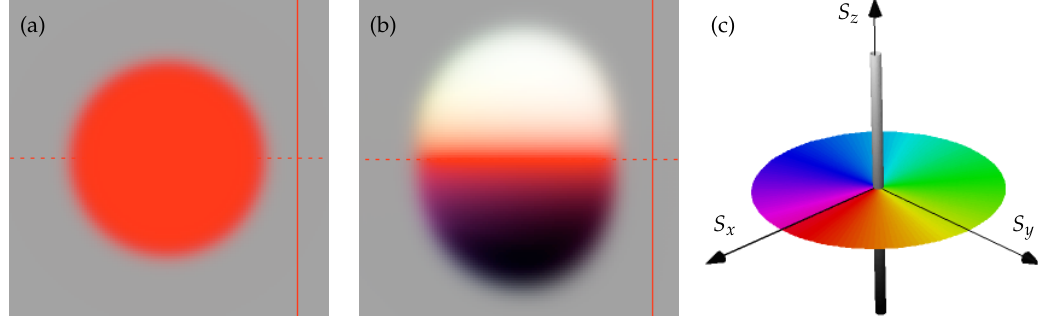
Figure 7. ( a ) An incident wavepacket with homogeneous polarization along the x -direction and ( b ) a reflected wavepacket with twisted spin texture. ( c ) Relative correspondence between spin density S and hue, lightness, and saturation (HLS) color space. Approximately, HLS correspond to the azimuth angle, polar angle, and magnitude of spin density,